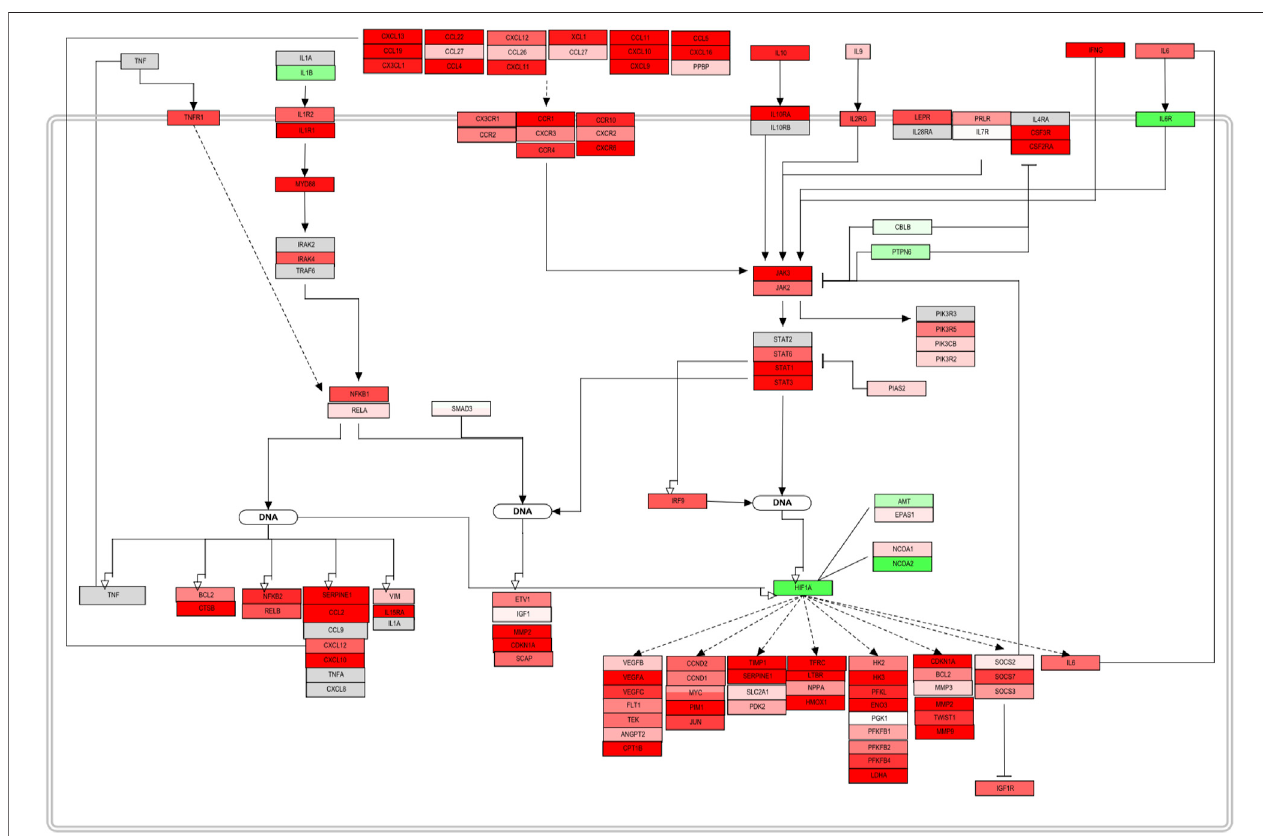
FIGURE4| PathVisioeditedpathwayoftheobtainedbiomarkerlist.NFKBandJAK/STATsectionofthecompletepathwaymapfrom SupplementaryFigureS1 . Thissectionofapathwaycontextualizesandrepresentstheup-regulationtrendofthemoleculesincludedinthemap.Moleculeswithanadjusted p -value < 0.05fromthe FS index score calculation were